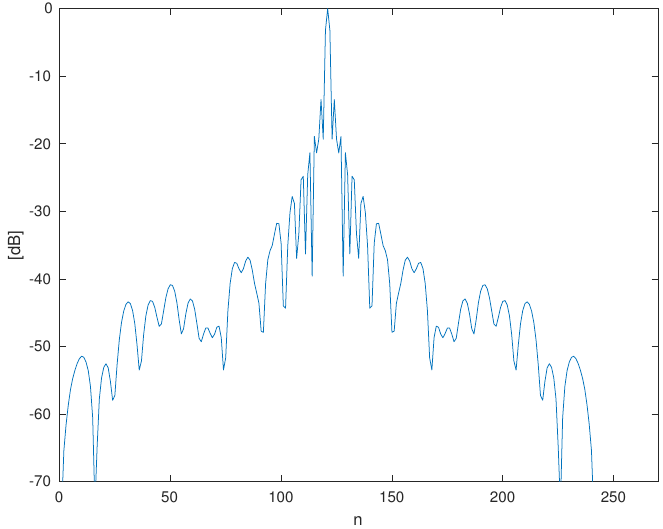
Figure 9. Amplitude of the spectrum of the near field along the observation line after applying the parameterization ξ